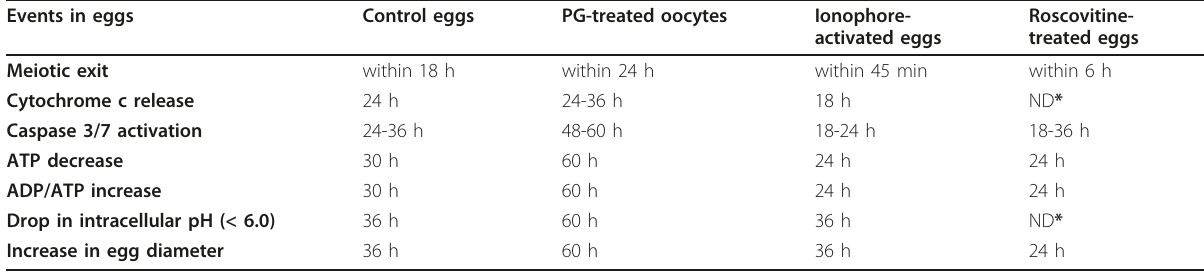
Table 2 Timing of apoptotic events in the ovulated Xenopus eggs and in vitro -matured oocytes. Events in eggs Control eggs PG-treated